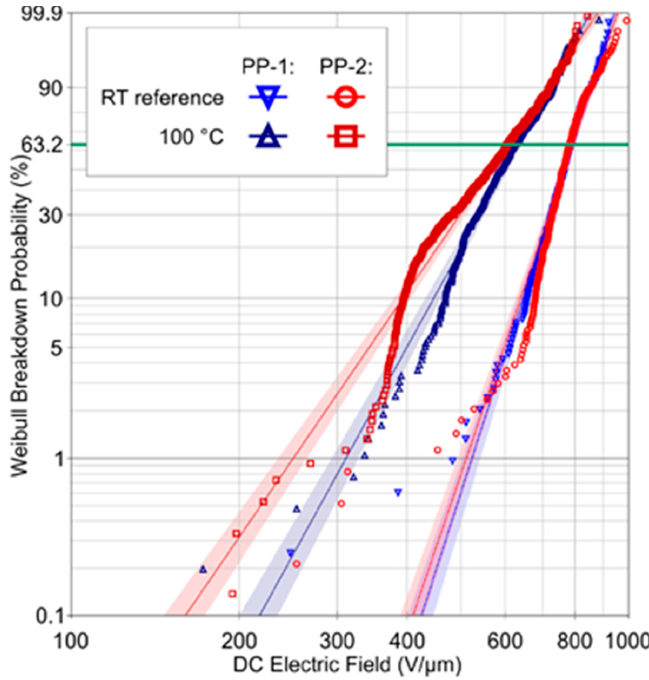
Figure 10. Weibull distribution of breakdown voltages at room temperature and at 100 °C for biaxially oriented PP (BOPP) film [26].